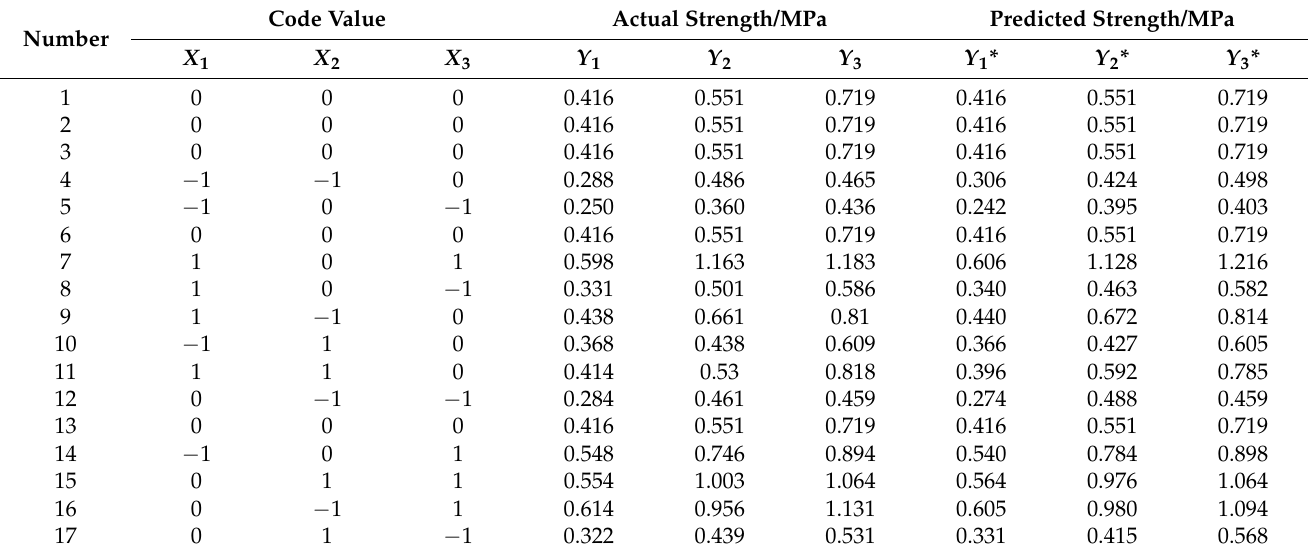
Table 5. Test design results and predicted values.